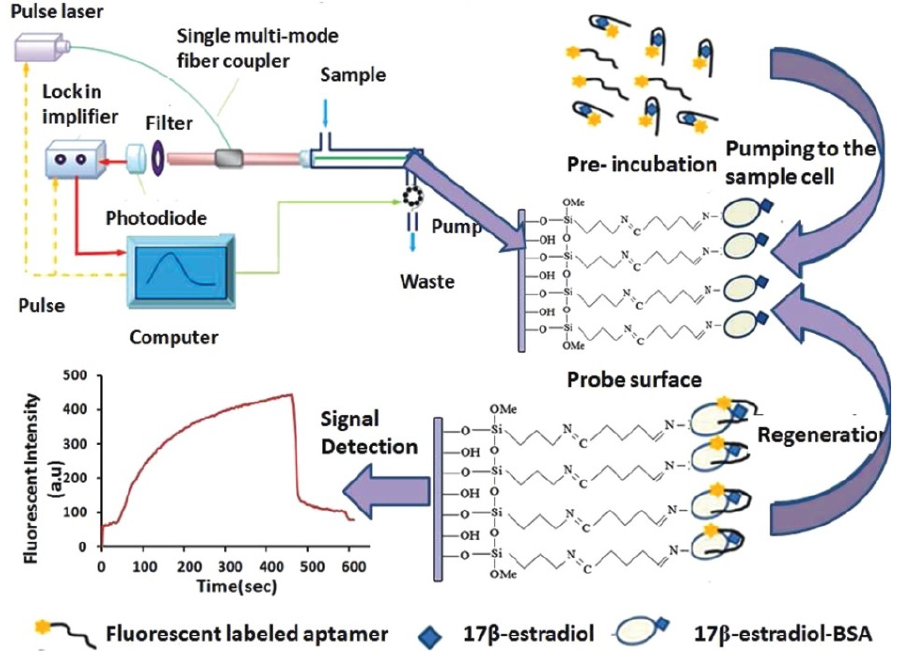
Figure 10. Aptamer-based FOEW sensor for rapid and sensitive detection of 17 β -estradiol in water samples. Reprinted from Yildirim et al. (2012) [85], Copyright (2018), with permission from American Chemical Society. Table 1. Detection of small